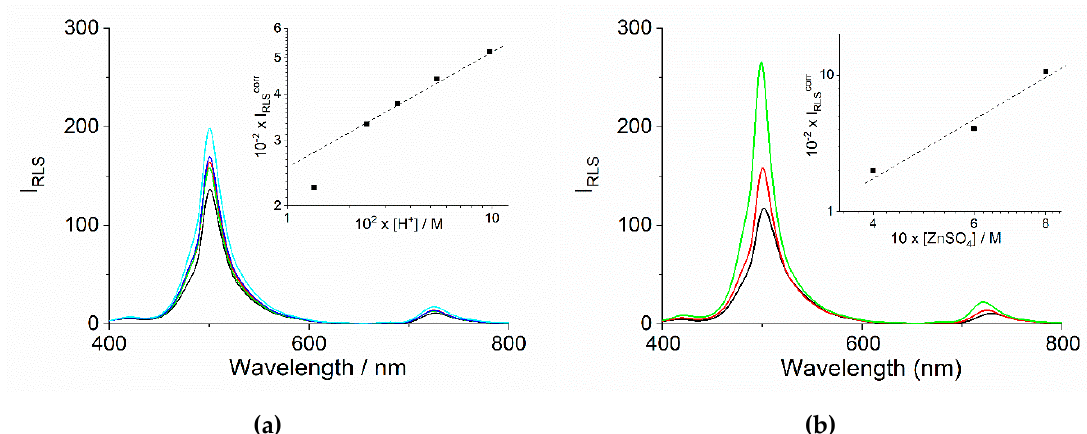
Figure 6. RLS spectra of the samples at the end of the aggregation process for the experiments at variable [H + ] ([H 2 SO 4 ] = 0.01 (black), 0.02 (green), 0.03 (red), 0.05 (blue) and 0.1 M (cyan)) and fixed ionic strength (IS = 0.6 M) ( a ) and at variable ionic strength [ZnSO 4 ] = 0.4 M (black), 0.6 M (red) and 0.8 M (green) and fixed [H + ] ([H 2 SO 4 ] = 0.05 M) ( b ). The inset of both frames report the log–log plots of the RLS intensity at maxima corrected for the extinction of the samples as function of [H + ] (left) and [ZnSO 4 ] (right).